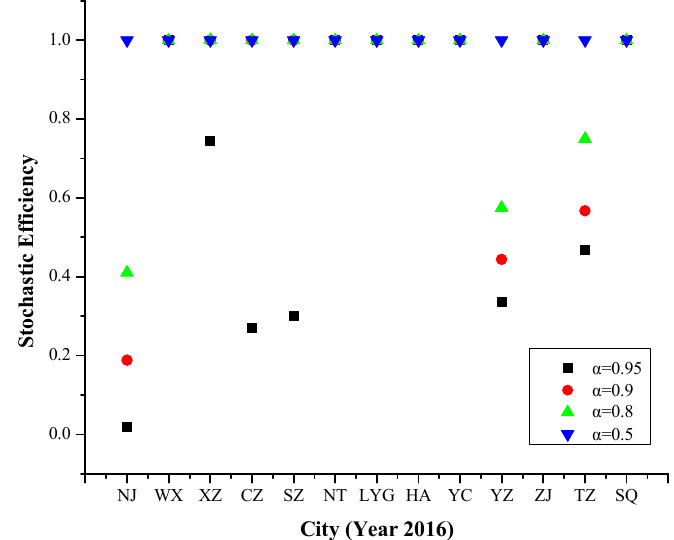
Figure 5. Stochastic efficiency values of 13 cities in Jiangsu Province at different risk levels in 2016.